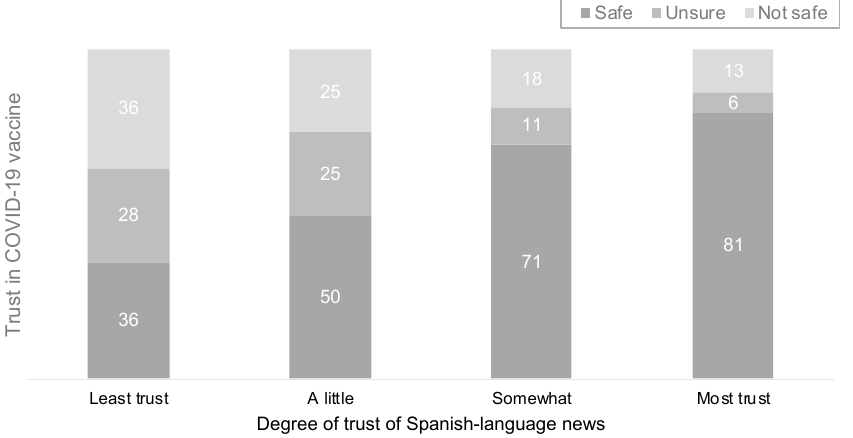
Figure 5. Covid-19 vaccine trust by trust in Spanish-language news among Latino adults (June 2021). Source: American COVID-19 Vaccine Poll. Notes: results presented in percentages from the question